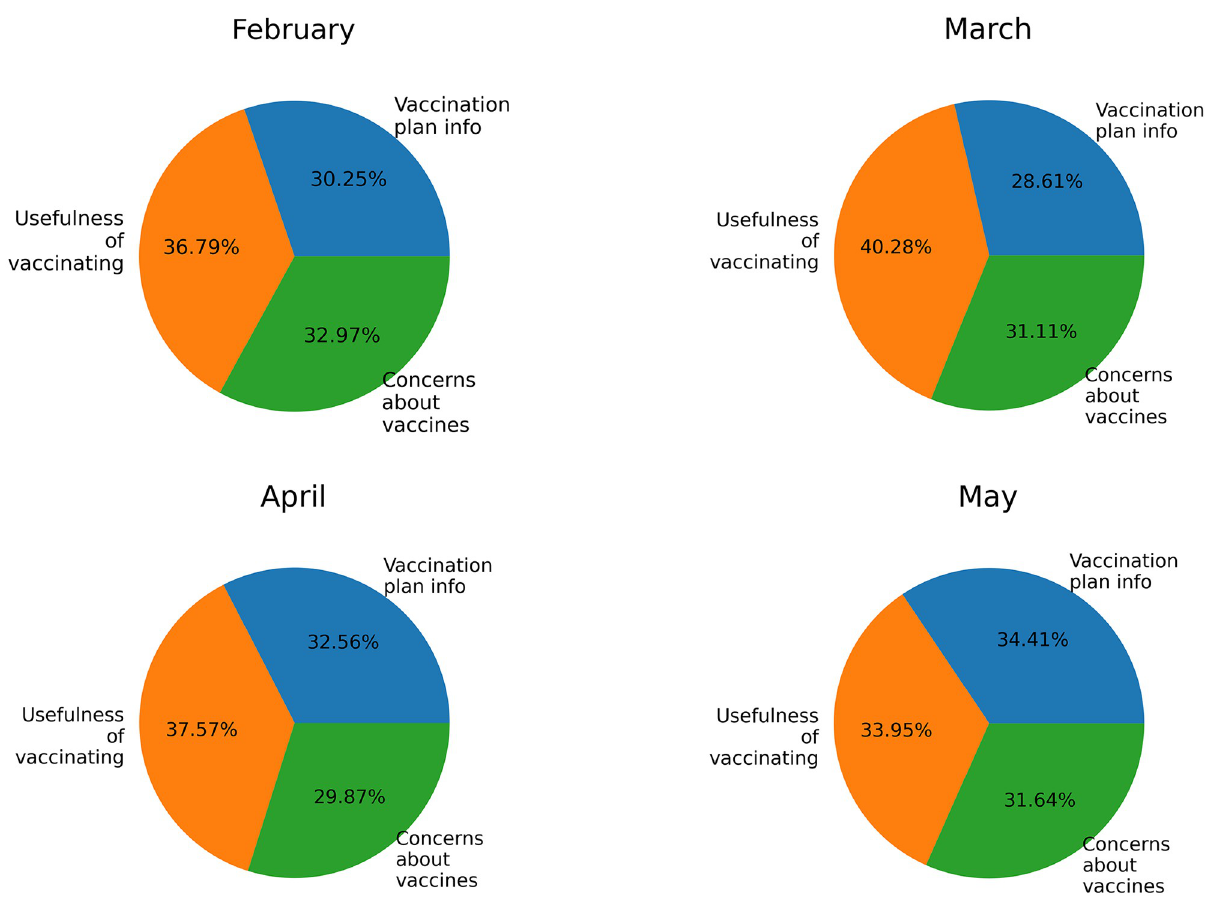
Fig 10. Dynamic volume of each topic over